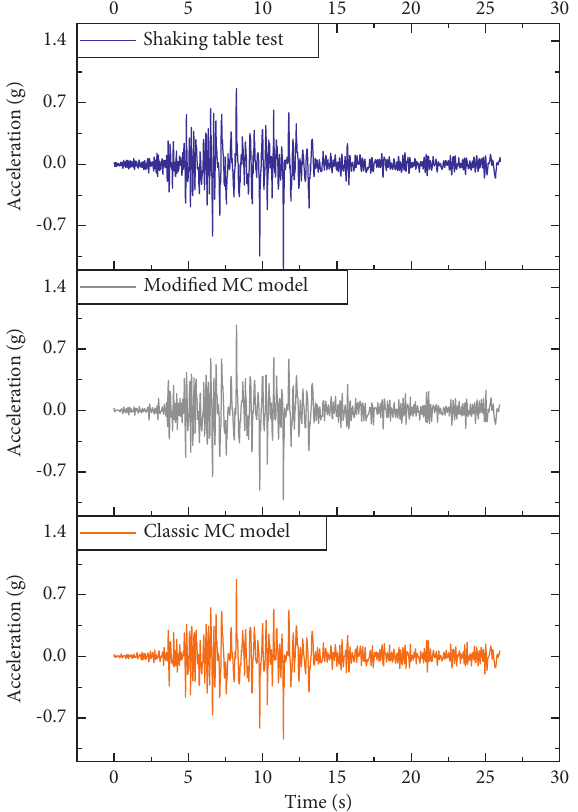
Figure 16: Acceleration time history at point A6H.